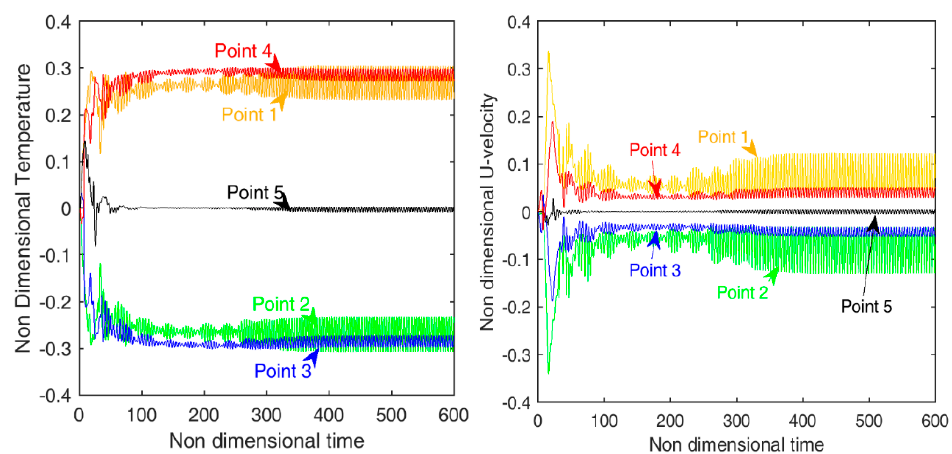
Figure 5. ( left ) Oscillation of ND Temperature values and ( right ) Oscillation of ND U values at designated points 1–5 with reference to the ND Time indicating the oscillatory behaviour of the solution and the occurrence of convergence. Table 4. Comparison of Point data at reference point 1 with standard results available from Christon et al. [28] Contributor